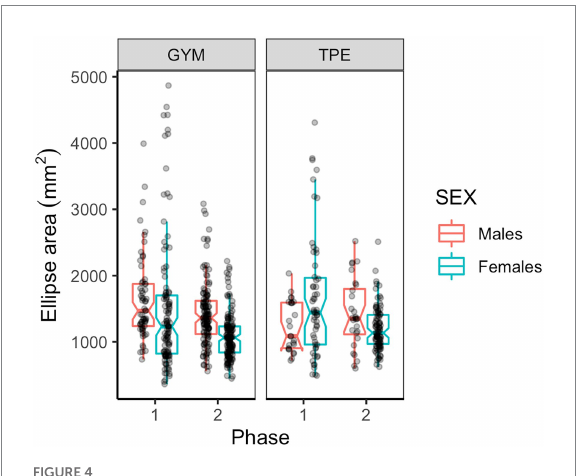
FIGURE 2 Anterior – posterior sample entropy for males and females in the GYM and TPE groups.